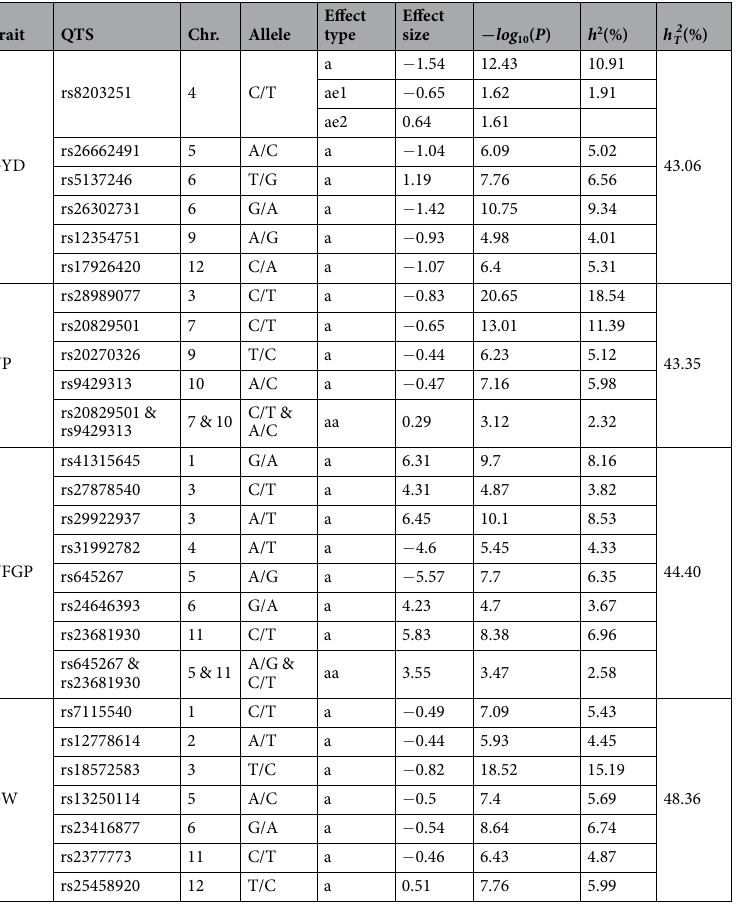
Table 3. The estimated heritability and predicted genetic effects of all detected significant SNP loci for four yield traits. QTS = the detected significant SNPs associated with the yield and yield components traits; Chr. = chromosome; Allele = paternal allele/maternal allele; a = additive effect for paternal allele homozygotes (QQ, ZH9308), ae = additive by environmental interaction effect, aa = additive by additive epistasis effect; − log 10 ( P ) = inverse of the base 10 logarithm of p value; h 2 (%) = heritability in percentage due to the genetic component effect; h equal to summation of heritabilities of all individual QTSs; GYD = grain yield, NP = number of panicles per plant, NFGP = number of filled grains per panicle, GW = grain